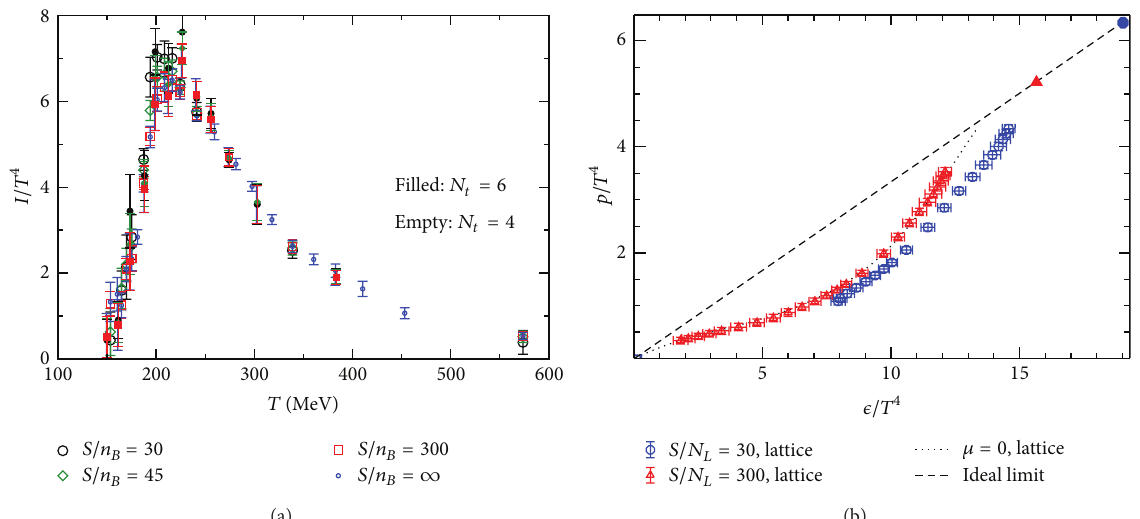
Figure 18: The EoS for different isentropes using asqtad quarks is shown in (a), from [66]. In (b), the data for the energy density and pressure is compared for different isentropes using stout-smeared staggered quarks, from